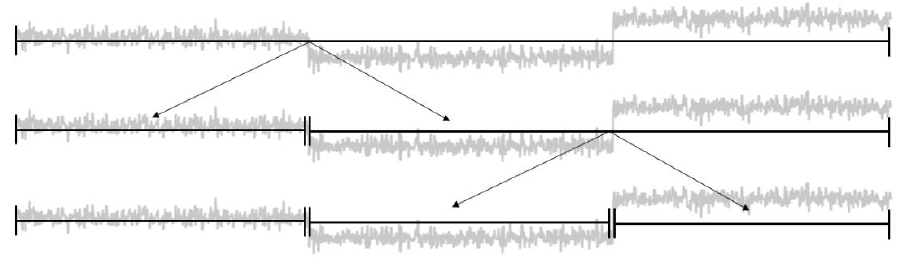
Figure 7. Top-down algorithm schema based on [5].